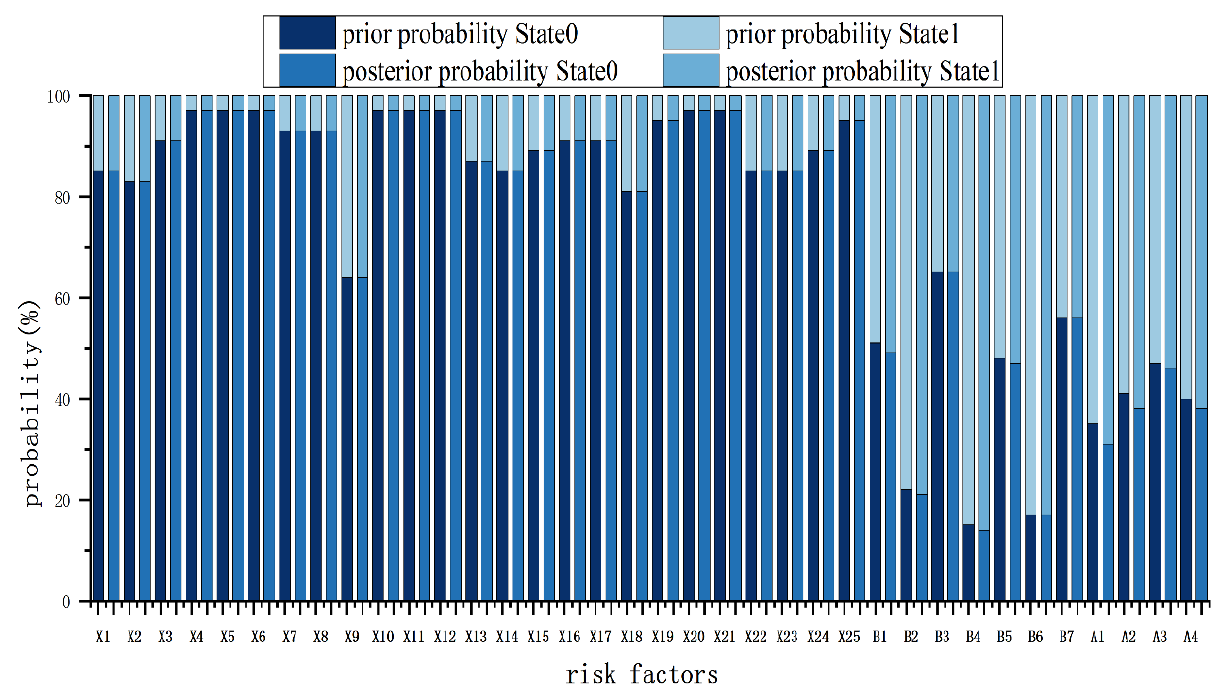
Figure 8. Comparison between prior probability and posterior probability of each node.